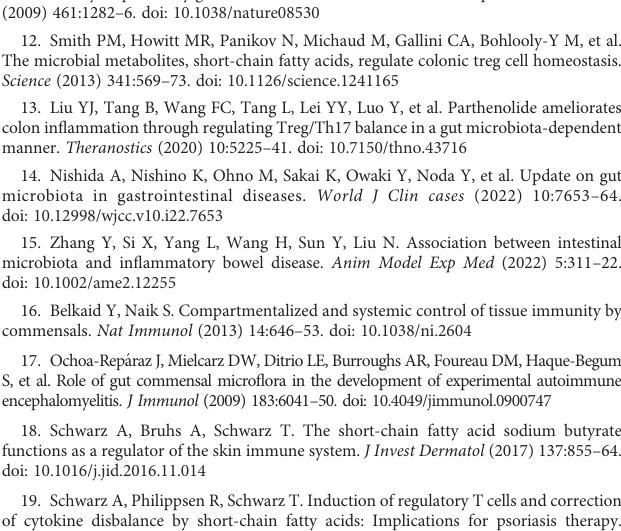
scatter graph with mean ± SD. Y axes show percentage of double positive cells. Data were analyzed by using the t test with Welch´s correction (n = 3). SUPPLEMENTARY FIGURE 2 The clinical response to IMQ was quanti fi ed according to a modi fi ed PASI score by Wang et al. (24). The data for Figures 1A, 3A, 5C, D, 7A, B are shown. SUPPLEMENTARY FIGURE 3 Pooled lymph node cells and splenocytes obtained from 4 WT and 4 HCA2-KO mice were gated for Foxp3 and analyzed for the expression of CTLA-4, Helios, Ki-67, PD-1, CD73, FR4. The total cell number of double positive cells is displayed in the histograms. FACS analysis is also shown as scatter graph with mean ± SD. Y axes show percentage of double positive cells. Data were analyzed by using the t test with Welch´s correction (n = 3). SUPPLEMENTARY FIGURE 4 (A) Treg obtained from 7 HCA2-KO and 7 WT mice were stained with CFSE and injected i.v. into IMQ-treated WT animals. After 48 h LN and spleens were obtained from the recipient mice and FACS analysis of CFSE-negative (overlay of red histograms) was conducted. The expression of IL-6, IL-17, IL-23 and IL-10 was standardized to isotype controls. For IL-6, IL-17 and IL-23 the same IgG (rat IgG1)controlwasused.Histogramsshow fl uorescenceintensity(xaxis)versuscell count (y-axis). The number of total cells is displayed in the histograms. (B) FACS analysisisalsoshownasscattergraphwithmean±SD.Yaxesshowpercentageof double positive cells. Data were analyzed by using the t test with Welch´s correction. 1 WT untreated; 2 WT +IMQ + w/o Treg (n = 3). SUPPLEMENTARY FIGURE 5 Treg were obtained from naïve HCA2-KO or from HCA2-KO mice injected i.p. with a rat monoclonal anti-IL-6 antibody. The isolated Treg were injected i.v. into IMQ-treated WT recipient mice. LN and spleen cells from these recipients were analyzed for double positive Foxp3/IL-10, Foxp3/GARP and Foxp3/CD25 cellsanddemonstratedaspercentageandtotalnumberofdoublepositivecells. SUPPLEMENTARY FIGURE 6 Pooled lymph node cells and splenocytes were obtained from 4 IMQ-treated WT and 4 HCA2-KO mice. Cells were gated for Foxp3 and FACS analysis performed for CD25, IL-17 and IL-23. The number of double positive cells is displayed in the histograms. FACS analysis is also shown as scatter graph with mean ± SD. Y axes show percentage of double positive cells. Data were analyzed by using the t test with Welch´s correction (n =